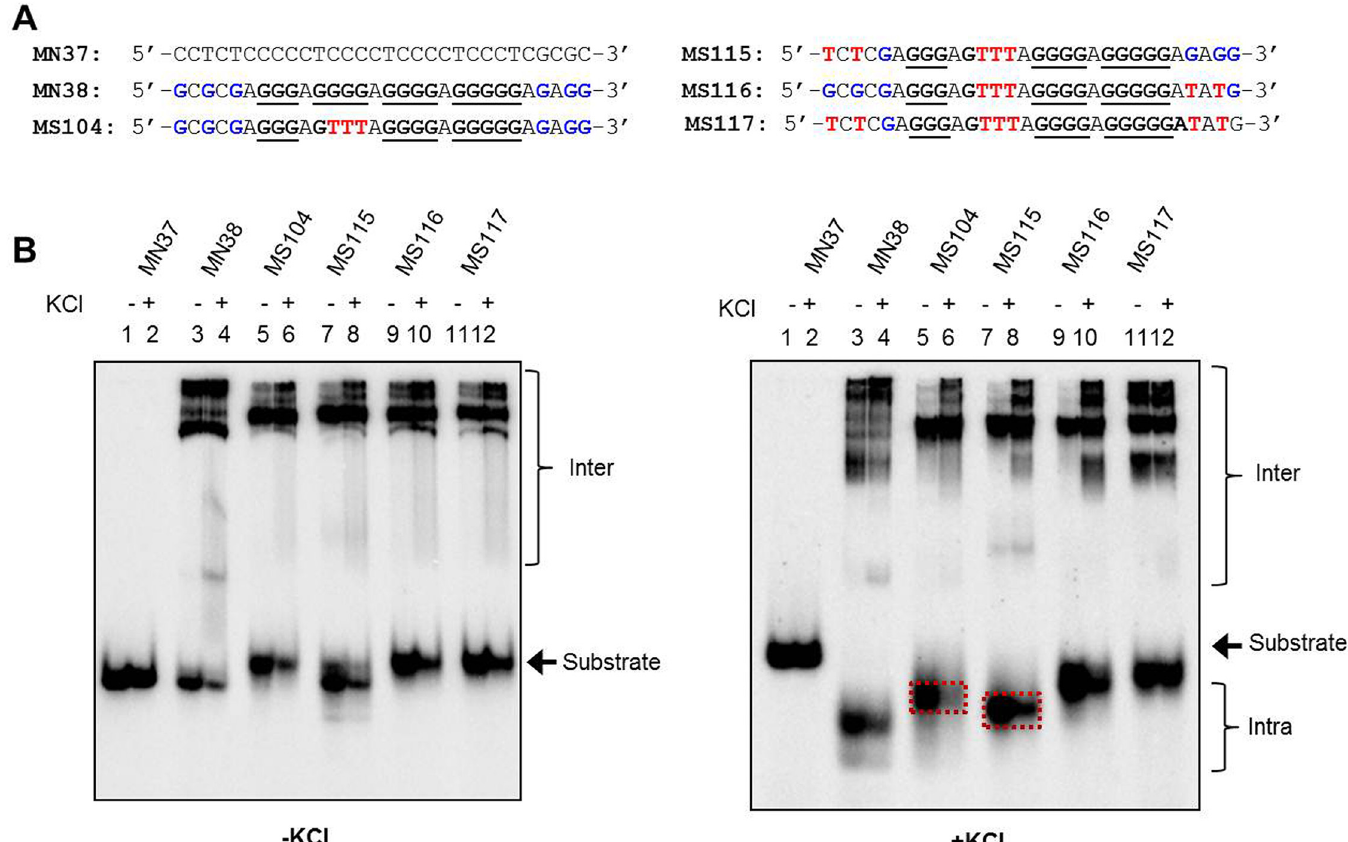
Fig 3. Analysis of involvement of GNG motif on G-quadruplex structure formation, when second stretch of guanines was mutated at HOX11 breakpoint region I. (A) The oligomeric DNA sequence spanning region I, a G-rich strand (MN38) and complementary C rich strand (MN37) were designed from the HOX11 breakpoint region. Mutants of MN38 were also designed and named as MS104, MS115, MS116, MS117. The mutations were introduced such that the second G stretch is altered to thymine (indicated in red) and keeping that as backbone either the first GNG motif (blue) or the second GNG motif (blue) or both are mutated (indicated in red). (B) The radiolabeled G- and C-rich strands along with the mutants were incubated in the presence (+) or absence (-) of KCl (100 mM) and resolved in the absence (left panel) or presence (right panel) of KCl (100 mM), in the gel and running buffer. The substrate, intramolecular (Intra), and intermolecular (Inter) quadruplex structures are indicated. The red boxed ‘ Intra ’ indicate intramolecular G-quadruplex species involving GNG motifs.